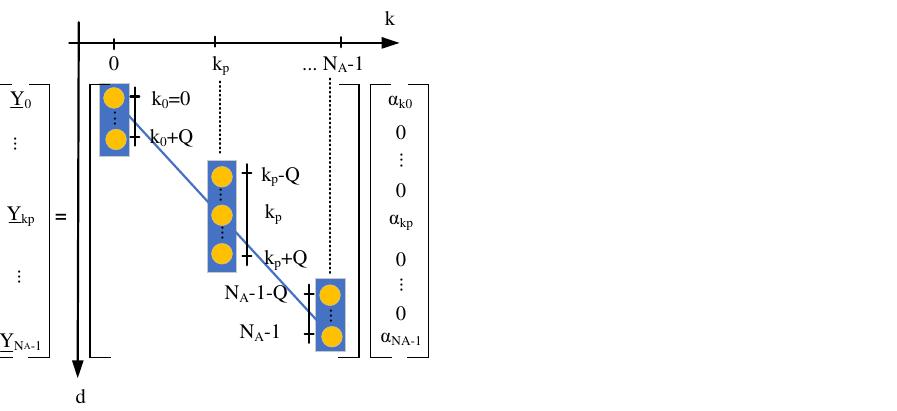
Figure 6. Sketch of proof for Remark 2: number of samples of the coupling